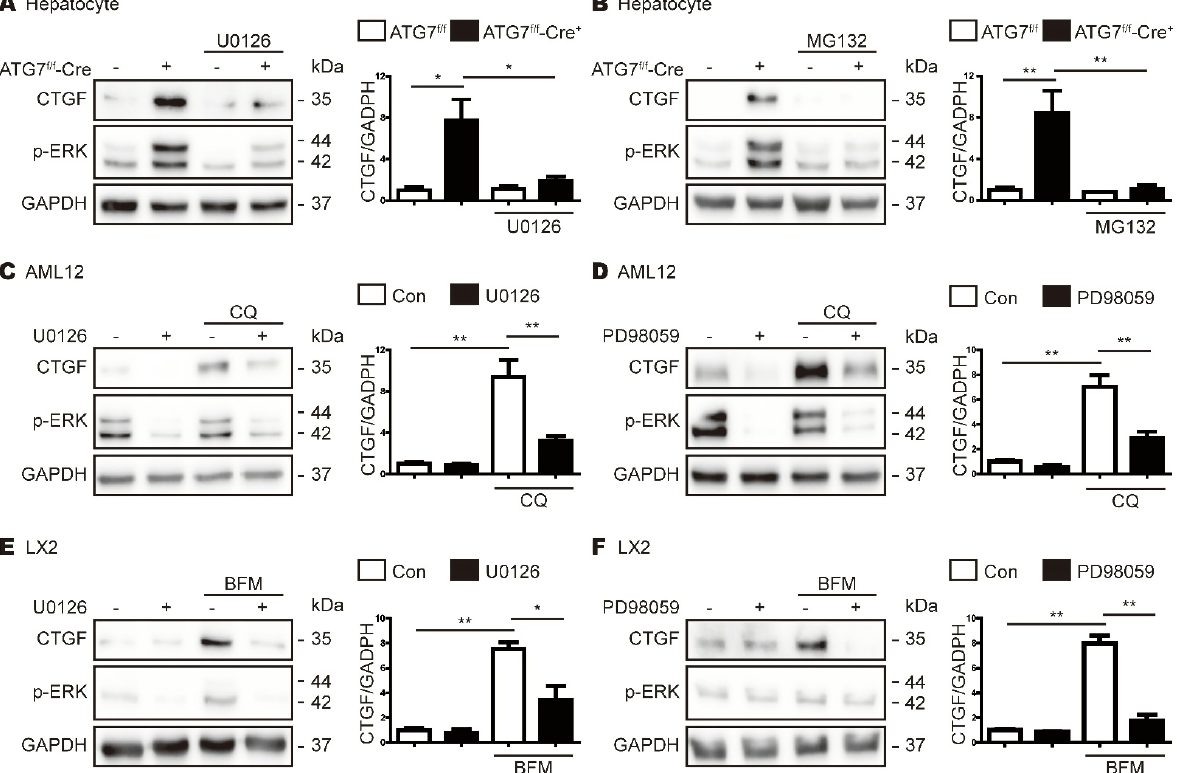
Figure 5. Increased CTGF expression caused by autophagy inhibition is associated with elevated p-ERK levels. ( A , B ) Western blot analyses of CTGF in primary hepatocytes from Cre-negative and Cre-positive ATG7 flox/flox (ATG7 f/f and ATG7 f/f -Cre + ) mice. The hepatocytes were treated with or without 10 µM U0126 ( A ) or 1 µM MG132 ( B ) for 24 h. The expression of tubulin was measured as a loading control. The data in the bar graphs represent the mean ± SEM of three independent measurements; * p < 0.05, ** p < 0.01. ( C , D ) Western blot analyses showing the effects of ERK inhibitors on the CQ-induced expression of CTGF. AML12 cells were treated with CQ and 10 µM U0126 ( C ) or 40 µM PD98059 ( D ) for 24 h. GAPDH expression was measured as a loading control. The data in the bar graph represent the mean ± SEM of three independent measurements; ** p < 0.01. ( E , F ) Western blot analyses showing the effects of ERK inhibitors on the BFM-induced expression of CTGF and p-ERK. LX2 cells were incubated with BFM and 10 µM U0126 ( E ) or 40 µM PD98059 ( F ) for 24 h. GAPDH expression was measured as a loading control. The data in the bar graph represent the mean ± SEM of three independent measurements; ** p < 0.01.